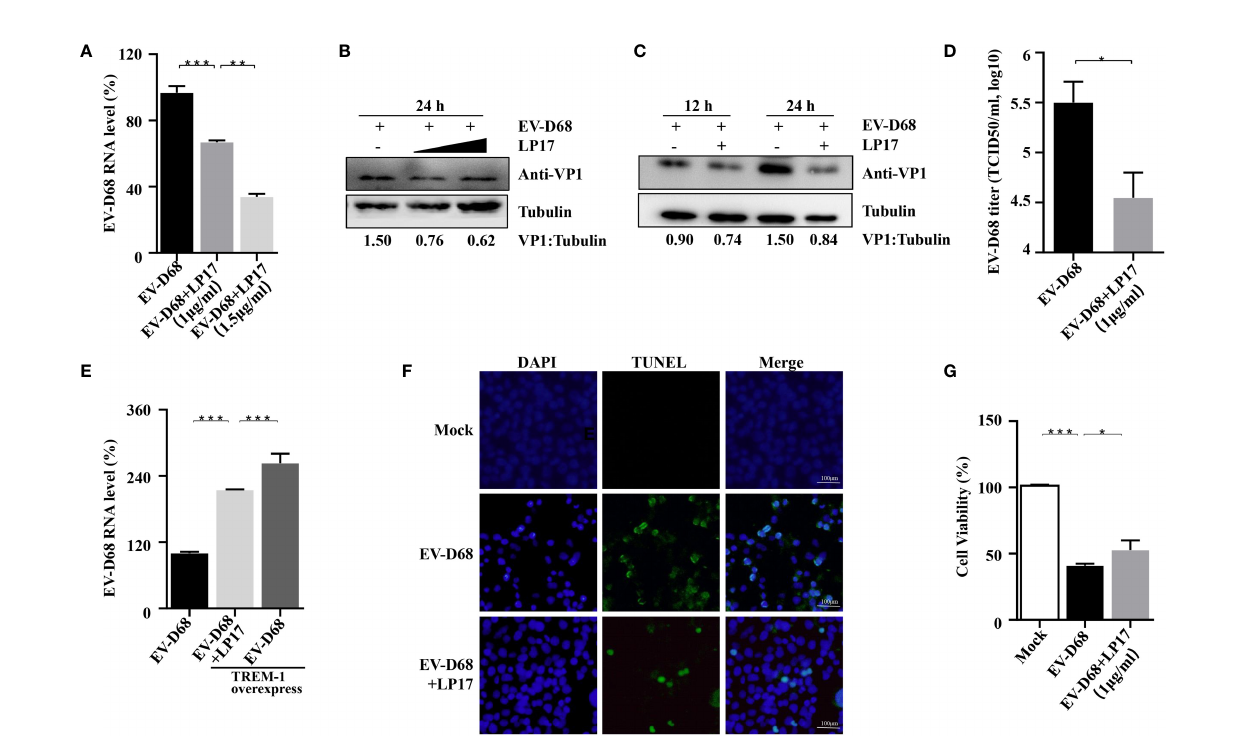
FIGURE 5 | TREM-1 inhibition impacts EV-D68 viral replication. (A, B) LP17 inhibits the replication of EV-D68 in a dose-dependent manner. LP17-pretreated RD cells (1 m g/ml or 1.5 m g/ml, 2 h) were exposed to EV-D68 for 24 h Cells were then harvested for RT-PCR analysis of relative EV-D68 RNA levels (A) , WB analysis of viral structural protein VP1 (B) , and TCID50 analysis of EV-D68 titers (D) . (C) RD cells were pretreated with LP17 for 2 h (1 m g/ml), then exposed to EV-D68 for 12 h or 24 h Cells were harvested for WB analysis. Tubulin was used as the sample loading control, and VP1 expression levels were normalized and against b -tubulin by ImageJ. (E) TREM-1 over-expression upregulates EV-D68 RNA levels. HEK293T cells were transfected with TREM-1_Flag or empty vector control (500 ng, 48-well plates) for 24 h Cells were then infected with EV-D68 (MOI = 0.1) for 24 h, harvested for RNA extraction, and subjected to RT-PCR analysis of relative EV-D68 RNA levels. (F, G) Effect of LP17 on apoptosis and cell viability of EV-D68-infected cells. RD cells were infected with EV-D68 following pretreatment with the synthetic peptide LP17 (1.0 m g/ml) for 2 h, and apoptosis and cell viability were determined by TUNEL and CCK-8 assay, respectively. (F) Fluorescent signals from TUNEL (green) and DAPI (blue) assays. Bars = 100 m m. The merged image shows the co-localization of nuclei and apoptotic cells. * p < 0.05, ** p < 0.01, *** p <